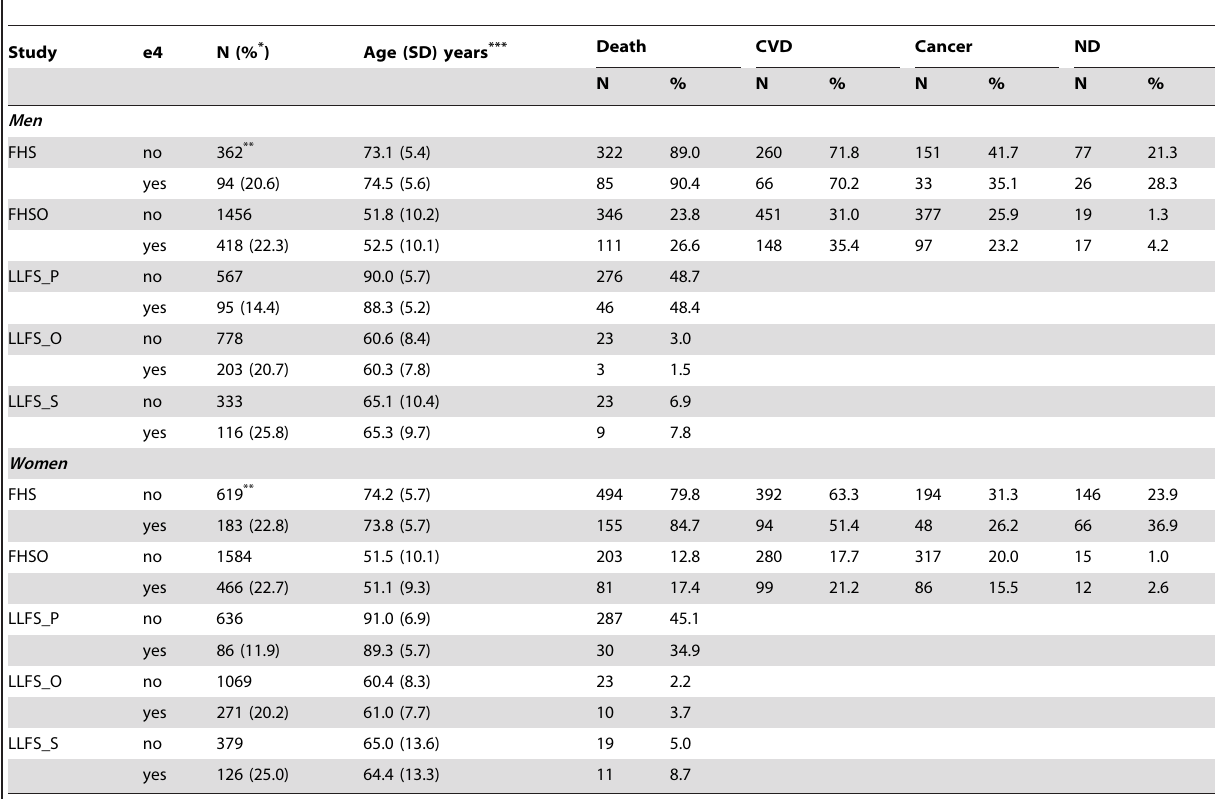
Table 1. Proportions of the ApoE4 allele carriers, mean age at the time of biospecimens collection, and the allele-specific proportions of deaths, CVD, cancer, and ND for the genotyped participants of the FHS, FHSO, and